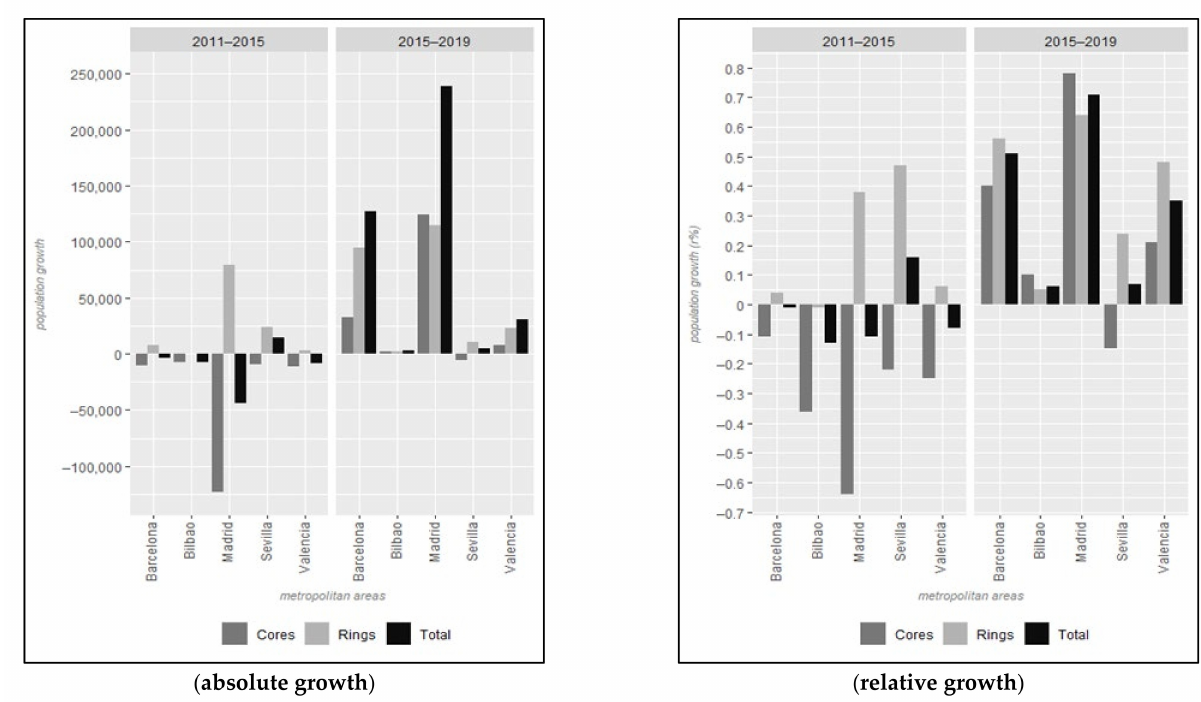
Figure 3. Core, ring, and the total FUA growth (for each of the five FUAs) in 2011–2015 and 2015–2019. Absolute numbers ( left graph ) and relative figures ( right graph ). Source: 2011, 2015, and 2019 Padr ó n Continuo (Continuous Population Register) microdata,